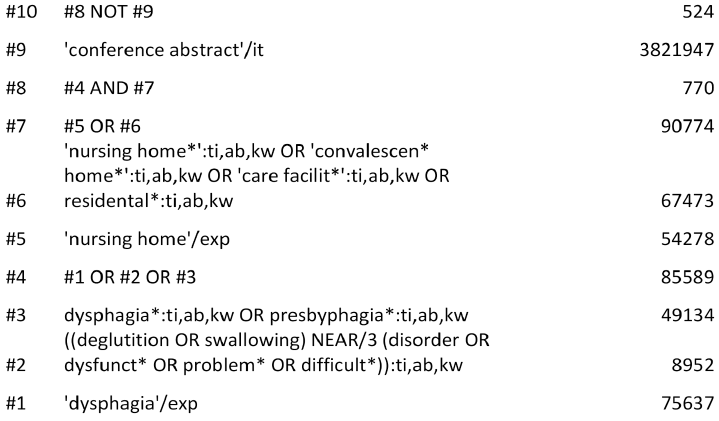
Figure 1. Search strategy